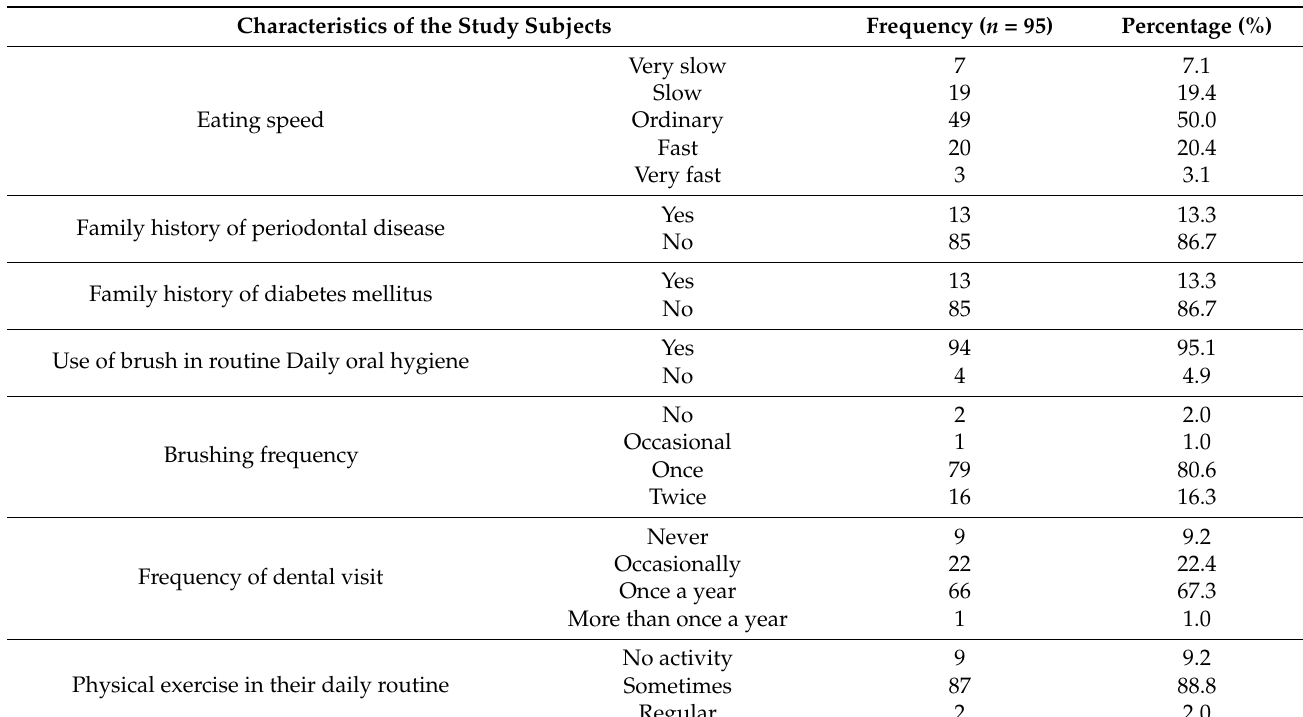
Table 2. Characteristics of the